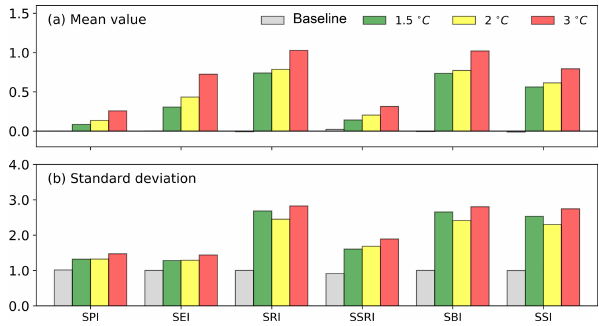
Figure 7. Comparison of (a) mean values and (b) standard devia- tions for hydrological indices averaged among climate models and RCP scenarios during the baseline period (1986–2005) and the pe- riods reaching 1.5, 2 and 3 ◦ C warming levels. SPI, SEI, SRI, SSRI, SBI and SSI represent standardized indices of precipitation, evap- otranspiration, runoff, surface runoff, baseflow (subsurface runoff) and streamflow,